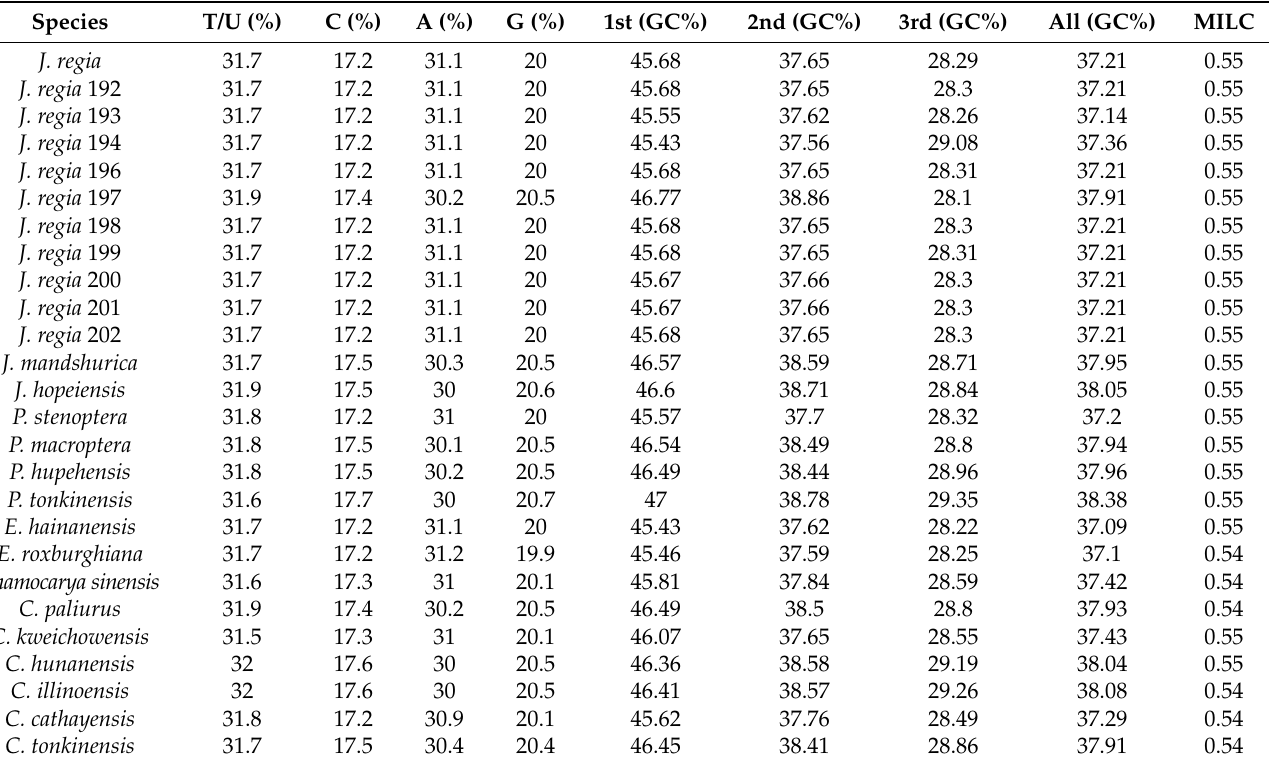
Table 2. Content of four nucleotides and GC content of CDSs at different positions in 26 Juglandaceae